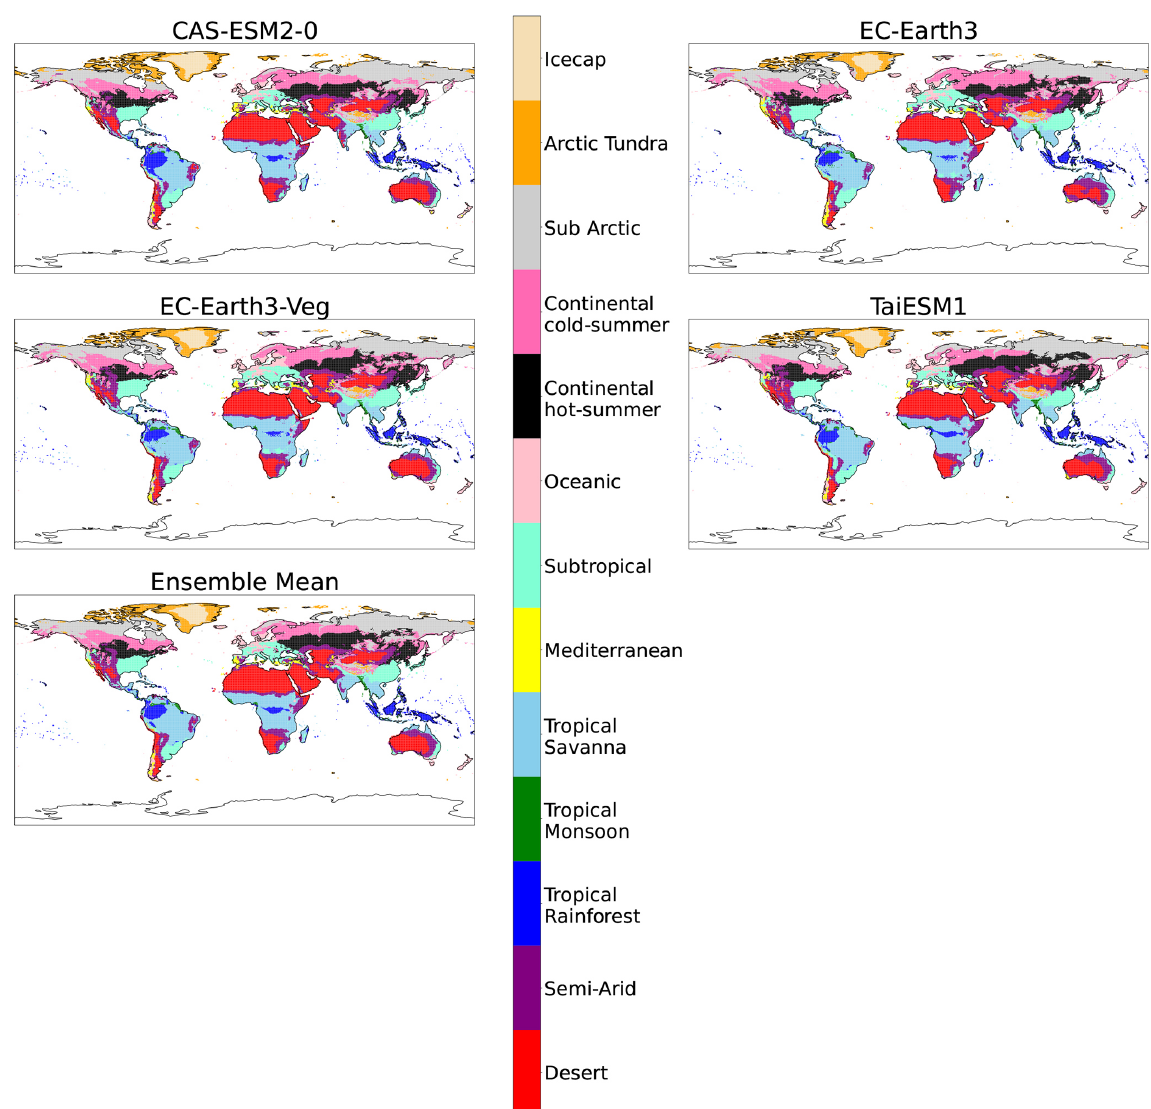
Figure B5. Maps of streamlined KG classifications for each model at + 3K with anomaly